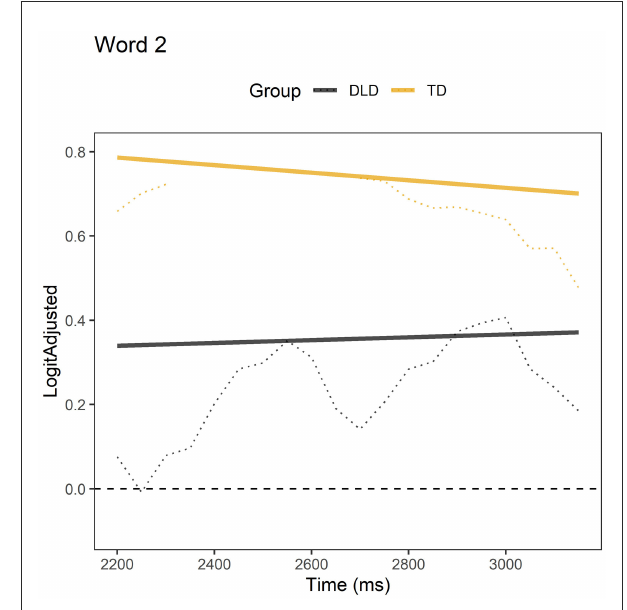
FIGURE7 Graph depicting looks towards the target picture per Group for Word2. The dotted line represents the actual data, the solid line represents the prediction of the statistical model.